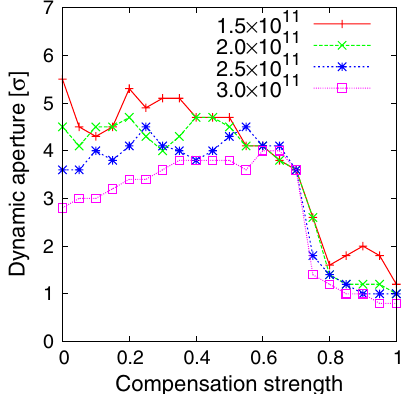
FIG. 7. Dynamic apertures without beam-beam compensation and with half and full beam-beam compensation. The proton bunch intensity ranges from 1 : 0 (cid:2) 10 11 to 3 : 0 (cid:2) 10 11 . The phase advance adjustment between IP8 and the e-lens is not included.